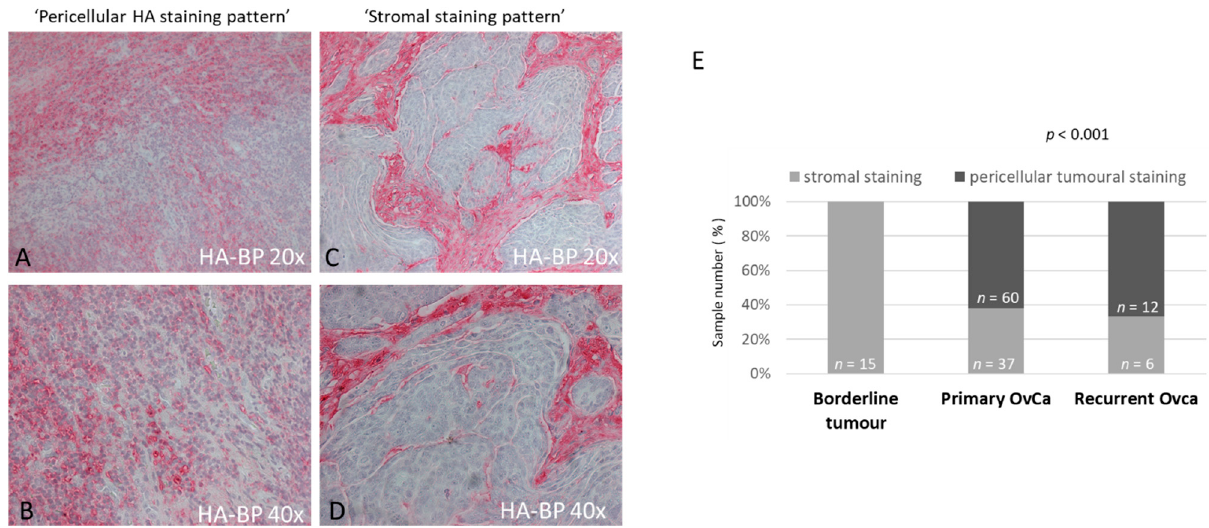
Figure 1. Hyaluronan deposition in ovarian tumors and its association with malignancy. Hyaluronan was detected by ligand histochemistry using a biotinylated hyaluronan-binding protein (HABP) in a patient cohort including 15 borderline tumors, and 102 primary and 20 recurrent ovarian cancer samples. Two staining patterns were detected: fine reticular peri-ovarian cancer-cell HA deposition ( A , B ) and coarse stromal HA deposition ( C , D ). A significant correlation between fine reticular peri-ovarian cancer-cell HA deposition and malignant potential could be observed ( E ). The p value after chi-square tests is provided; p < 0.05 was regarded as significant.